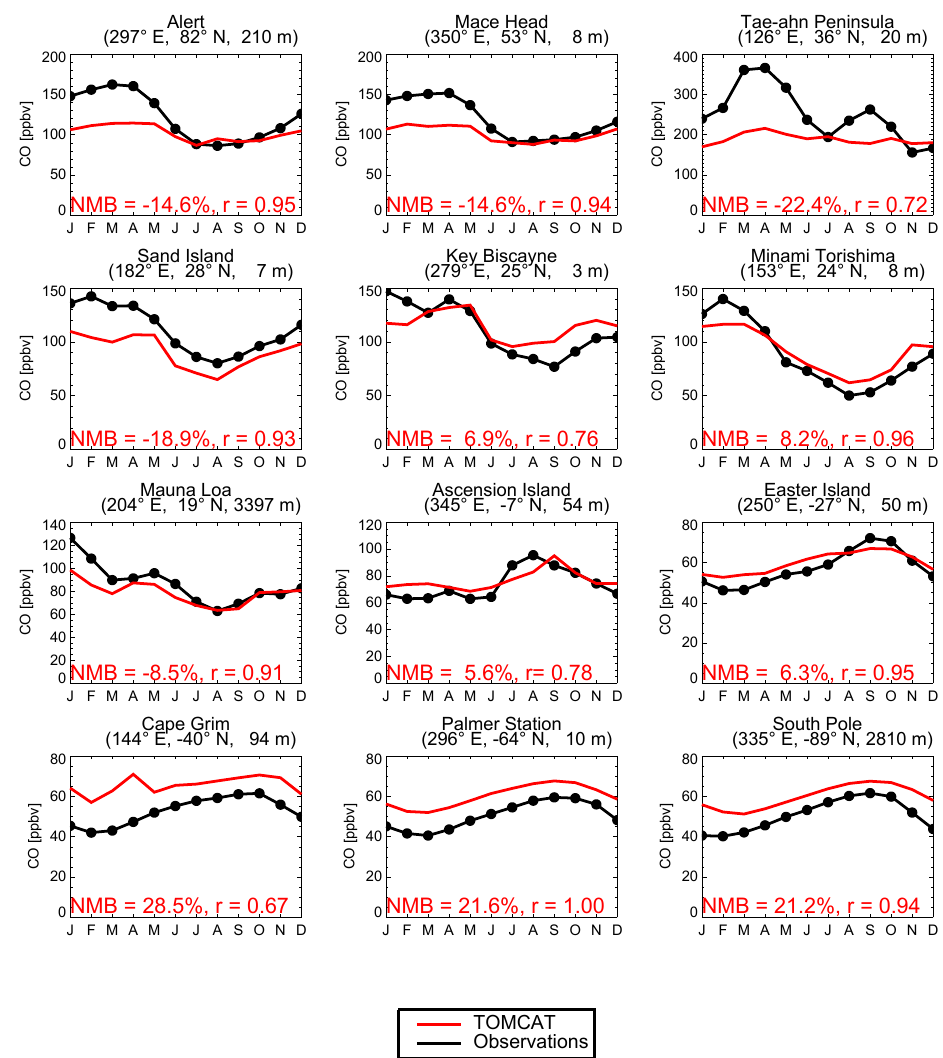
Figure 6. Monthly mean 2008 observed and simulated CO (ppbv) at several surface sites located throughout the globe. The panels are arranged by latitude from north to south, with Pearson correlation ( r ) and normalised mean bias (NMB) between the observed and simulated monthly mean data printed on each